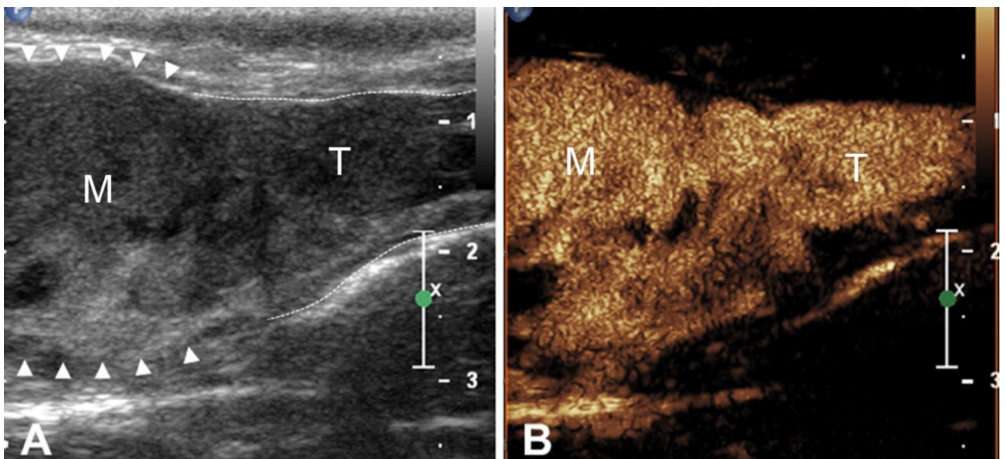
Figure 3. ( A ) Two-dimensional and ( B ) contrast-enhanced images of malignant thrombosis involving the thyroid in a dog with thyroid carcinoma (case 1). ( A ) The thyroid mass (arrows head) invades the lumen of the right thyroid vein (dotted); ( B ) contrast-enhanced ultrasound shows synchronous contrast uptake of the primary thyroid mass and the thrombus inside the thyroid